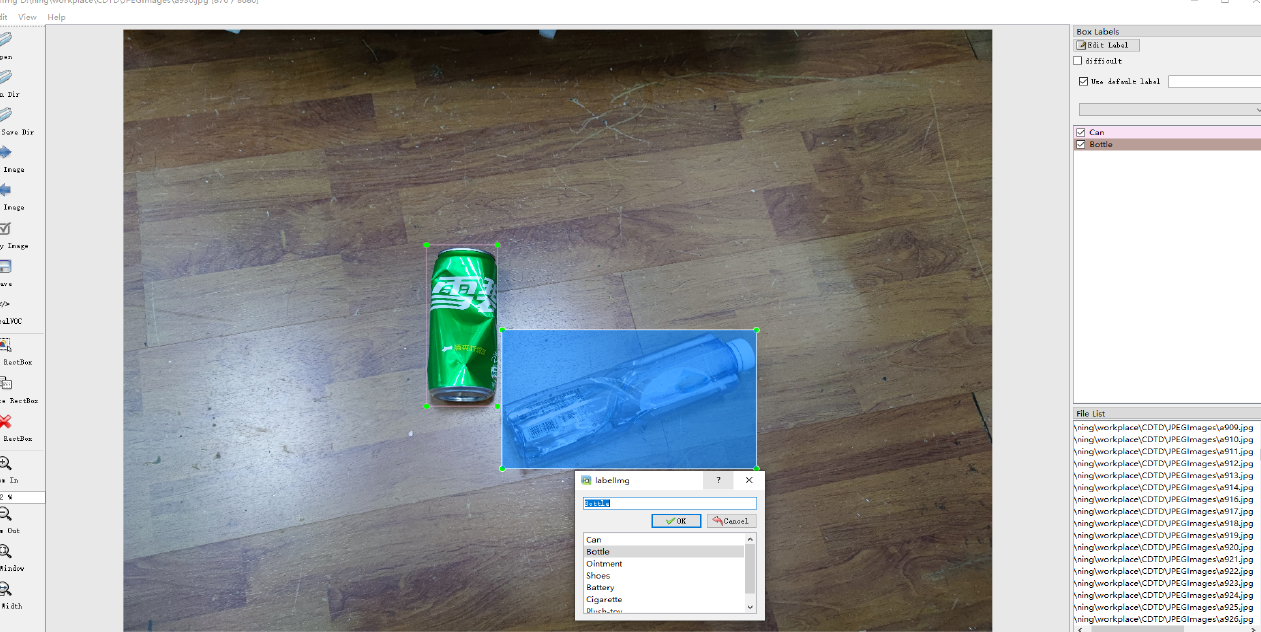
Figure 8. LabelImg software operating interface